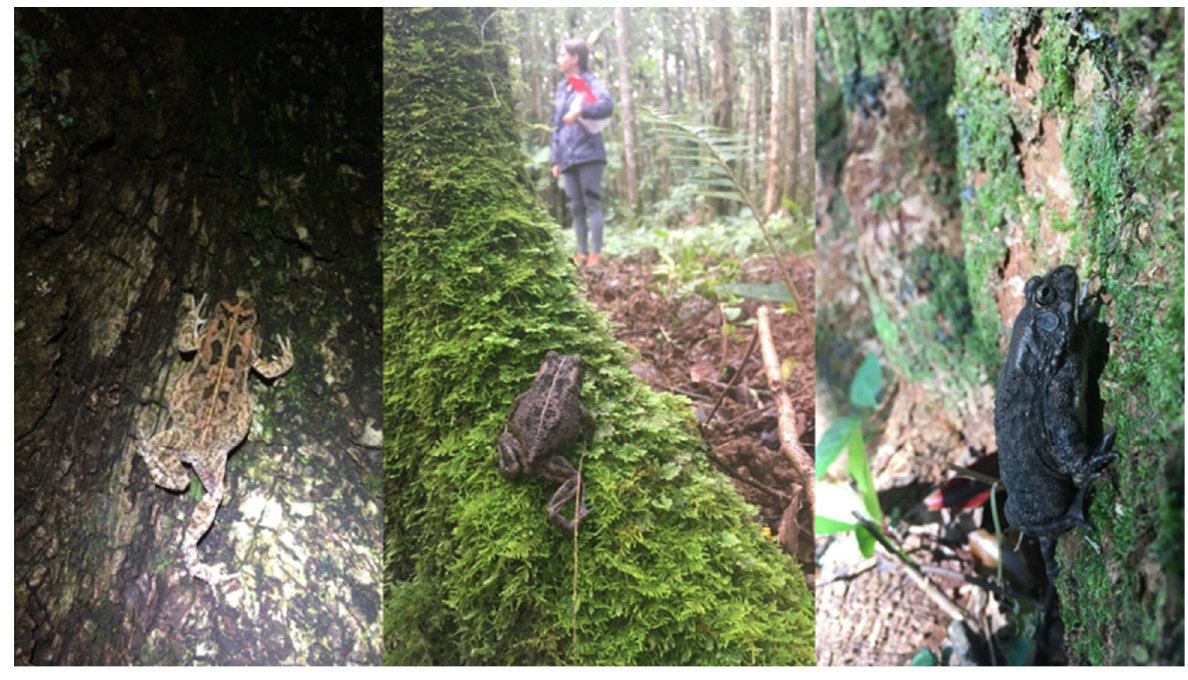
Figure 4. Observations of guttural toads ( Sclerophrys gutturalis ) engaging in antipredator behavior, which involved fleeing to the nearest tree and beginning to climb its trunk when startled by a researcher. Instances of this behavior were observed in the urban site within the toad’s native range in Durban (left), as well as natural sites in Mauritius (center) and Réunion (right).